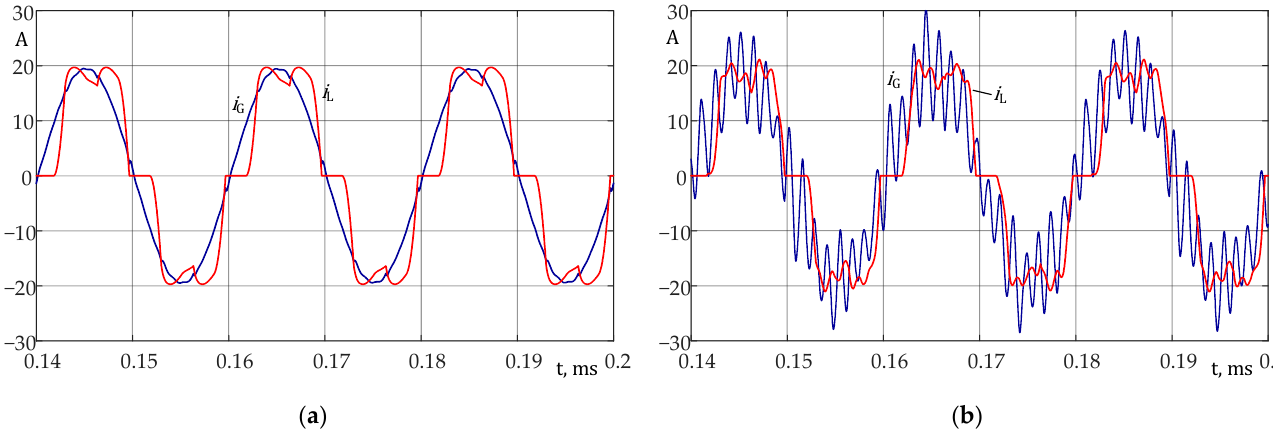
Figure 6. Simulations of operation of HAPF with CL1 control loop, K = 40: ( a ) with zero time delay T D = 0 μs, ( b ) with the time delay T D = 300 μs.